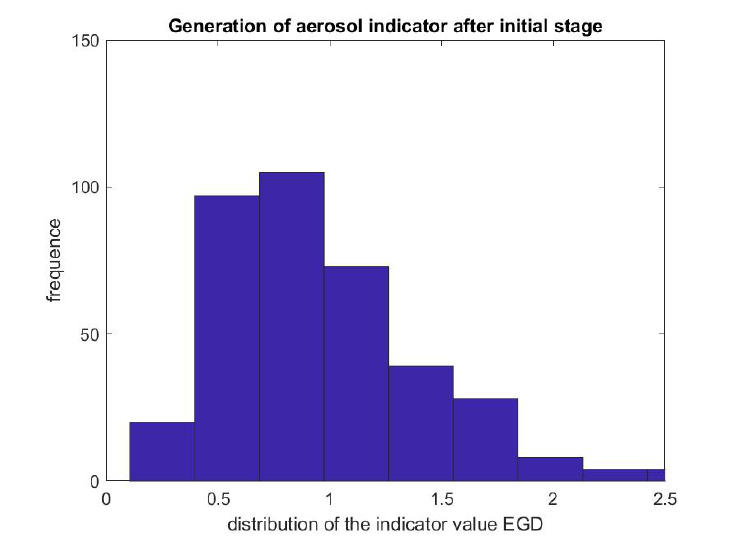
D col pre . D col proc